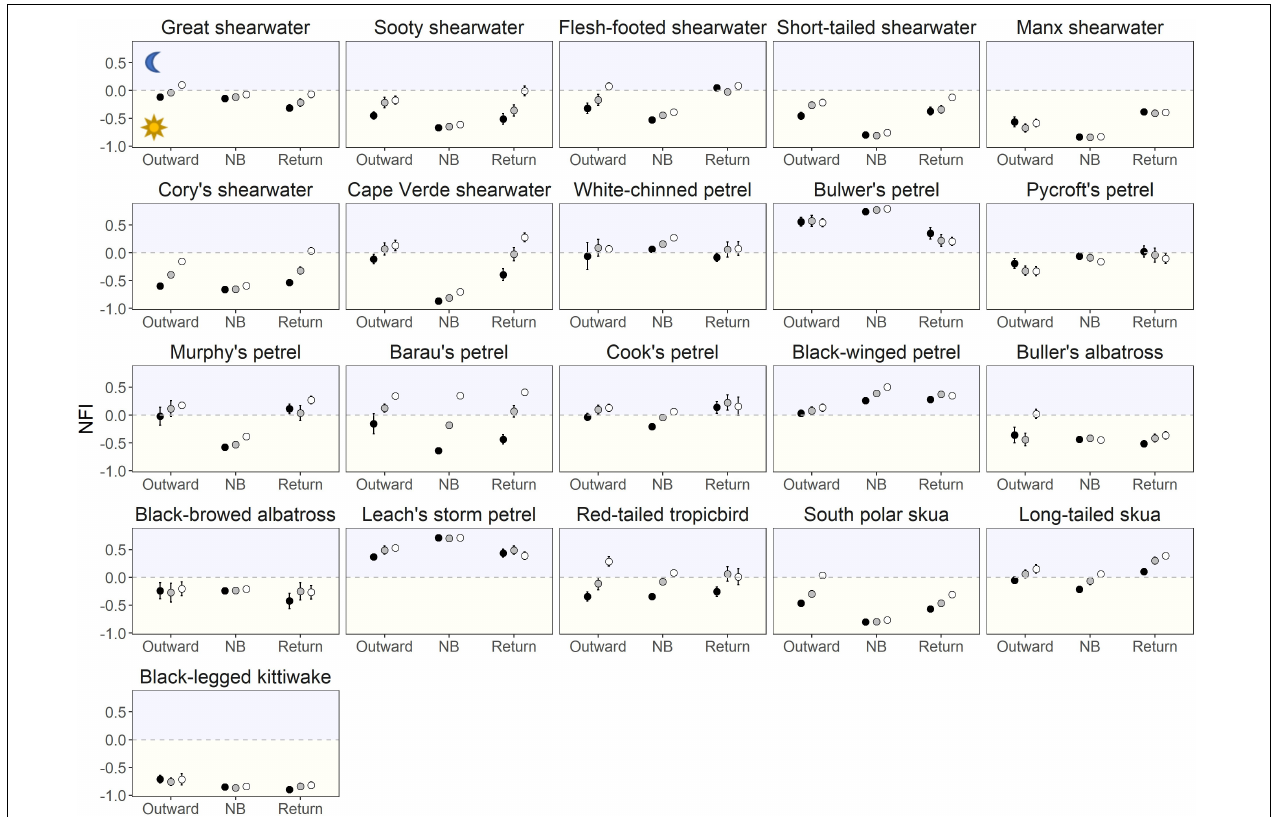
FIGURE 5 | Effect of migratory stages (outward migration, NB: non-breeding period, return migration) and the moon (new moon: black dots, moon quarters: grey dots, full moon: white dots) on the night flight index (NFI). Results are presented as mean ± 95% CI around the mean. The levels of significance of the differences are shown in Figures 1 , 6 . For scientific names, see Table 1